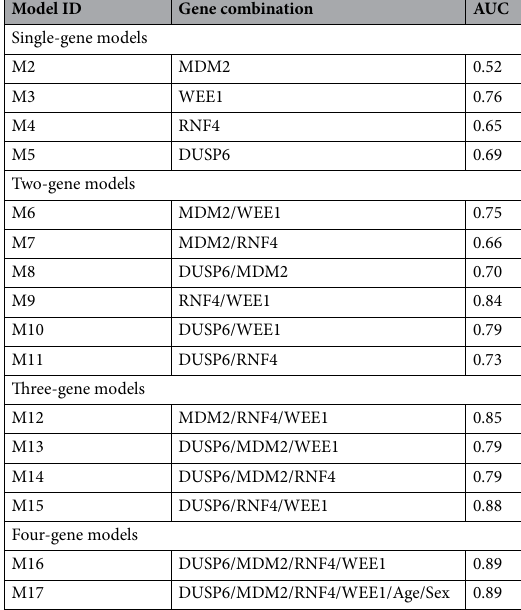
Table 4. AUCs of logistic